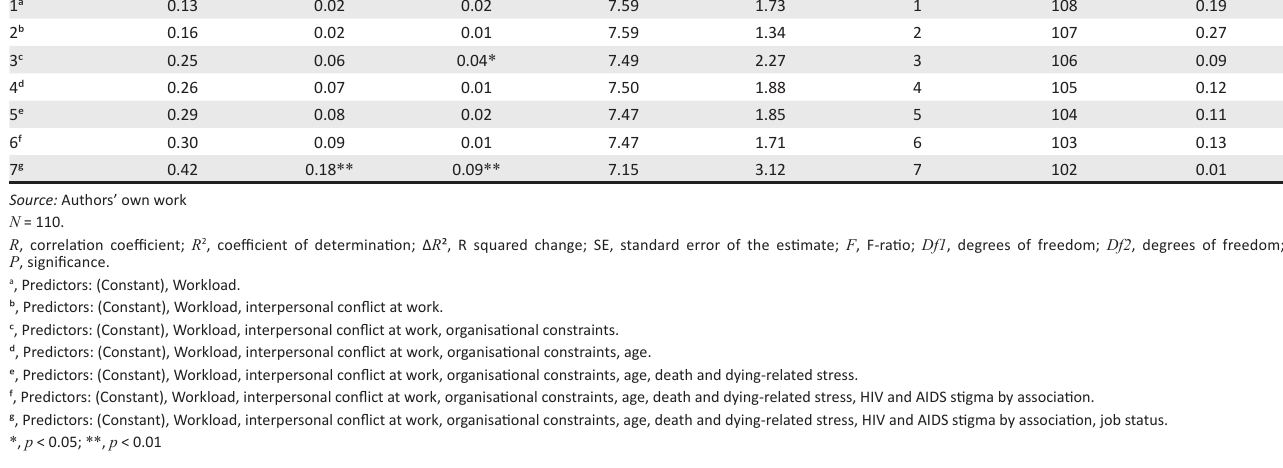
TABLE 3: Multiple regression analyses for variables predicting personal accomplishment.